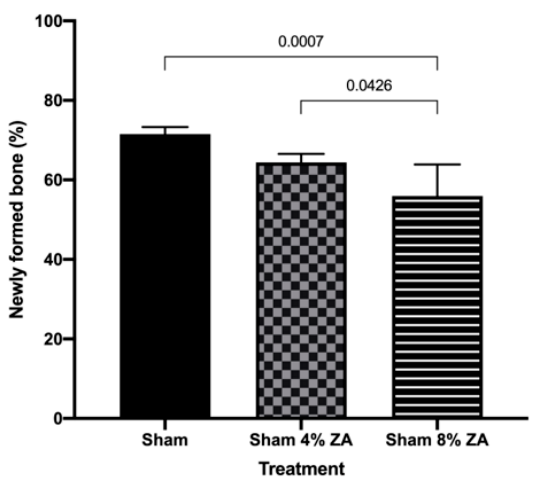
Figure 7. Newly formed bone in the Sham group (without ZA treatment), Sham 4%ZA and Sham 8% ZA treatments. The values are presented as mean ± C.I. The statistical differences between treatments are represented by horizontal bars. There were no statistical differences between clot 4% ZA and clot 8% ZA (ANOVA and Tukey’s post-test, p <0.05).